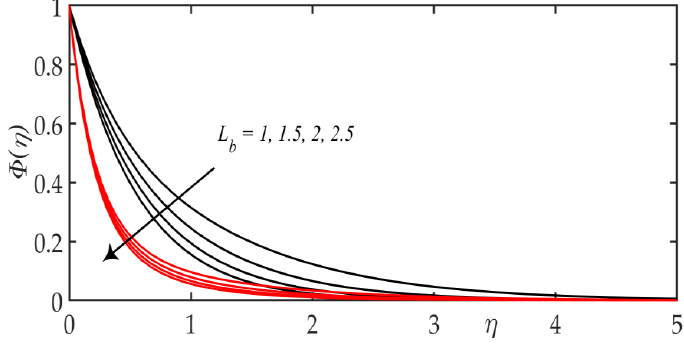
Figure 9. Variation of 𝑁 𝑏 and 𝐿 𝑒 on concentration profile. Solid line: 𝐿 𝑒 = 1.5 , Dotted line: 𝐿 𝑒 = 2.0.